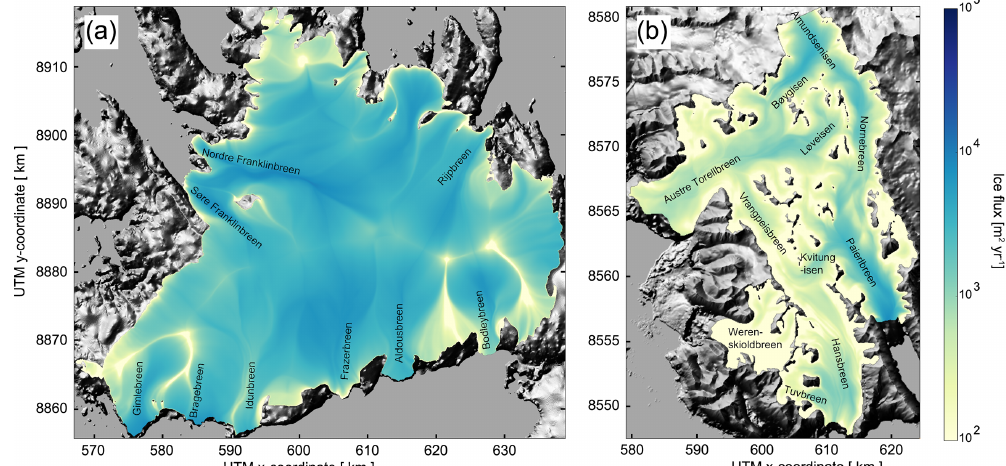
Figure 3. Ice-flux solution after cost optimisation for VIC (a) , THPB and WSB (b) . Starting at the ice crest on VIC, ice flux gradually increases and converges. Before the ocean is reached, the outflow is channelled through several major outlet glaciers. Flux values at marine ice fronts are a natural result of the mass overturning. Background: grey-scale hill-shaded topography based on a NPI 50m DEM (http: